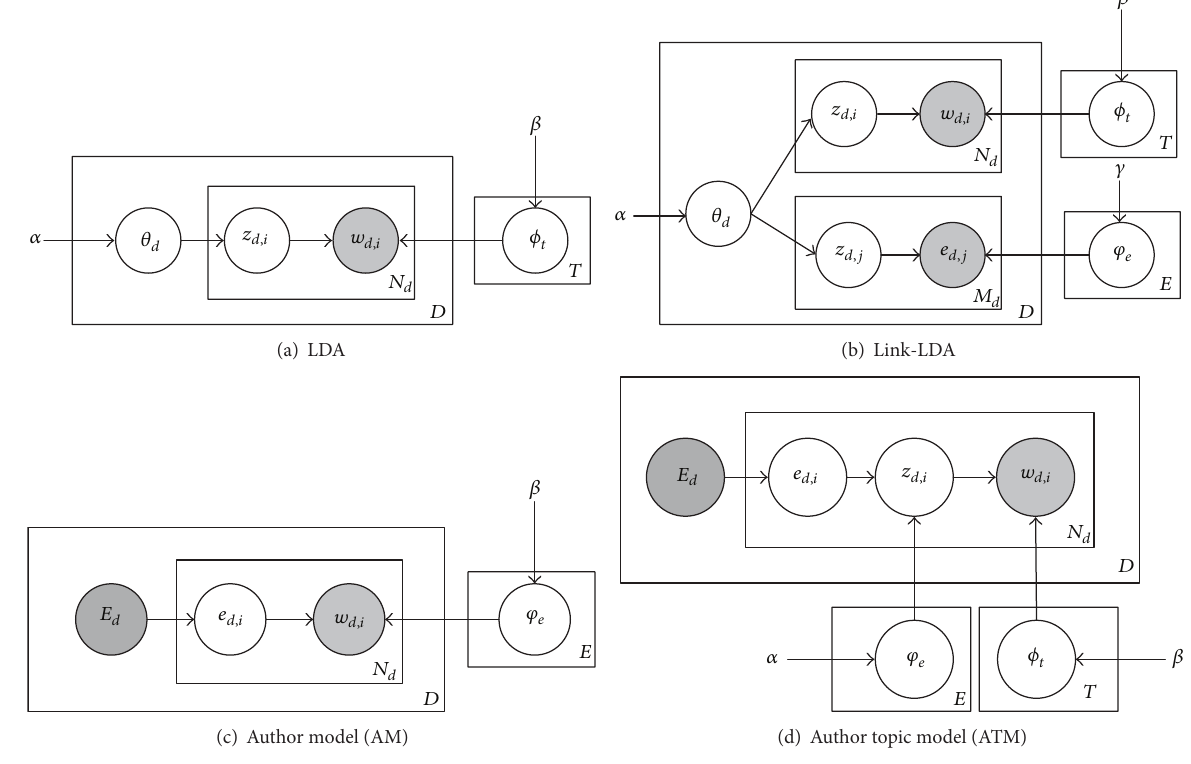
Figure 3: Four topic models associated with entities, topics, and